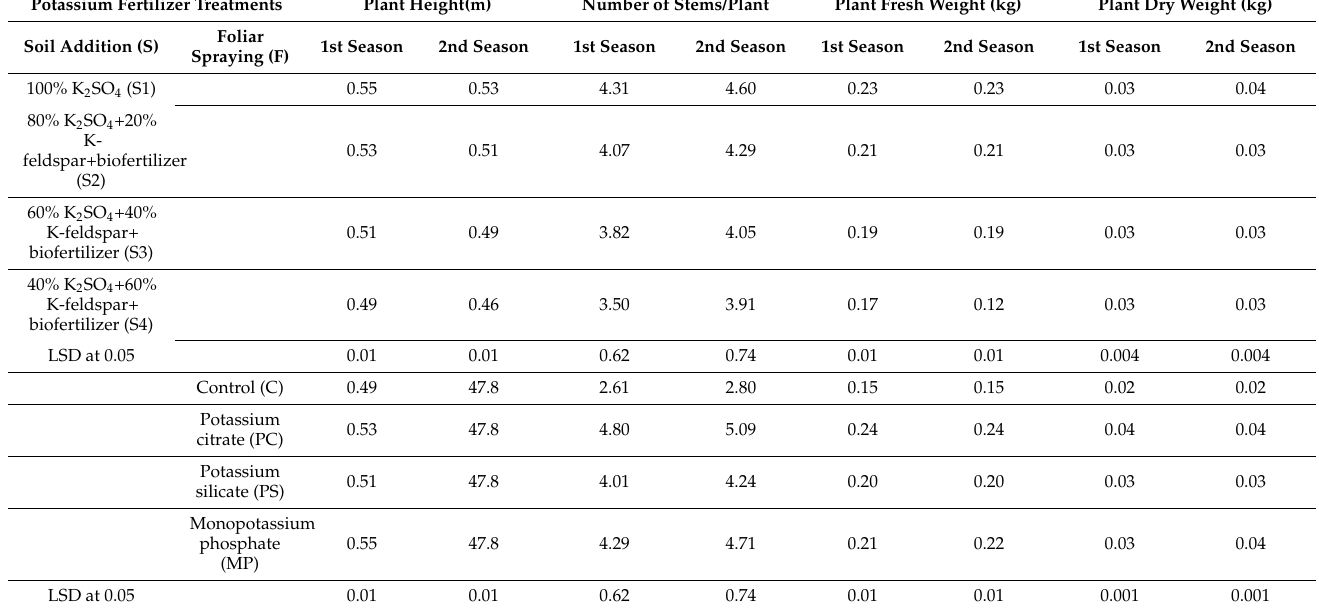
Table 3. The effect of potassium fertilization with soil addition (S) or foliar spraying (F) on growth parameters of potato plants during the 2018 and 2019 growing